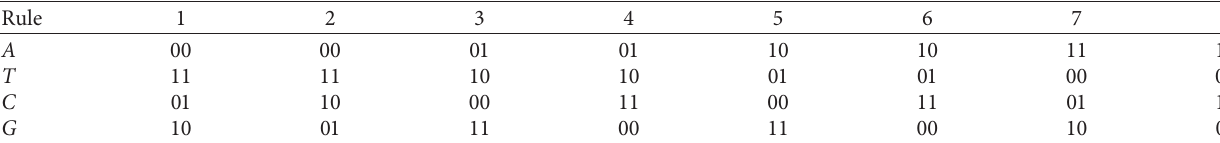
Table 1: DNA encode